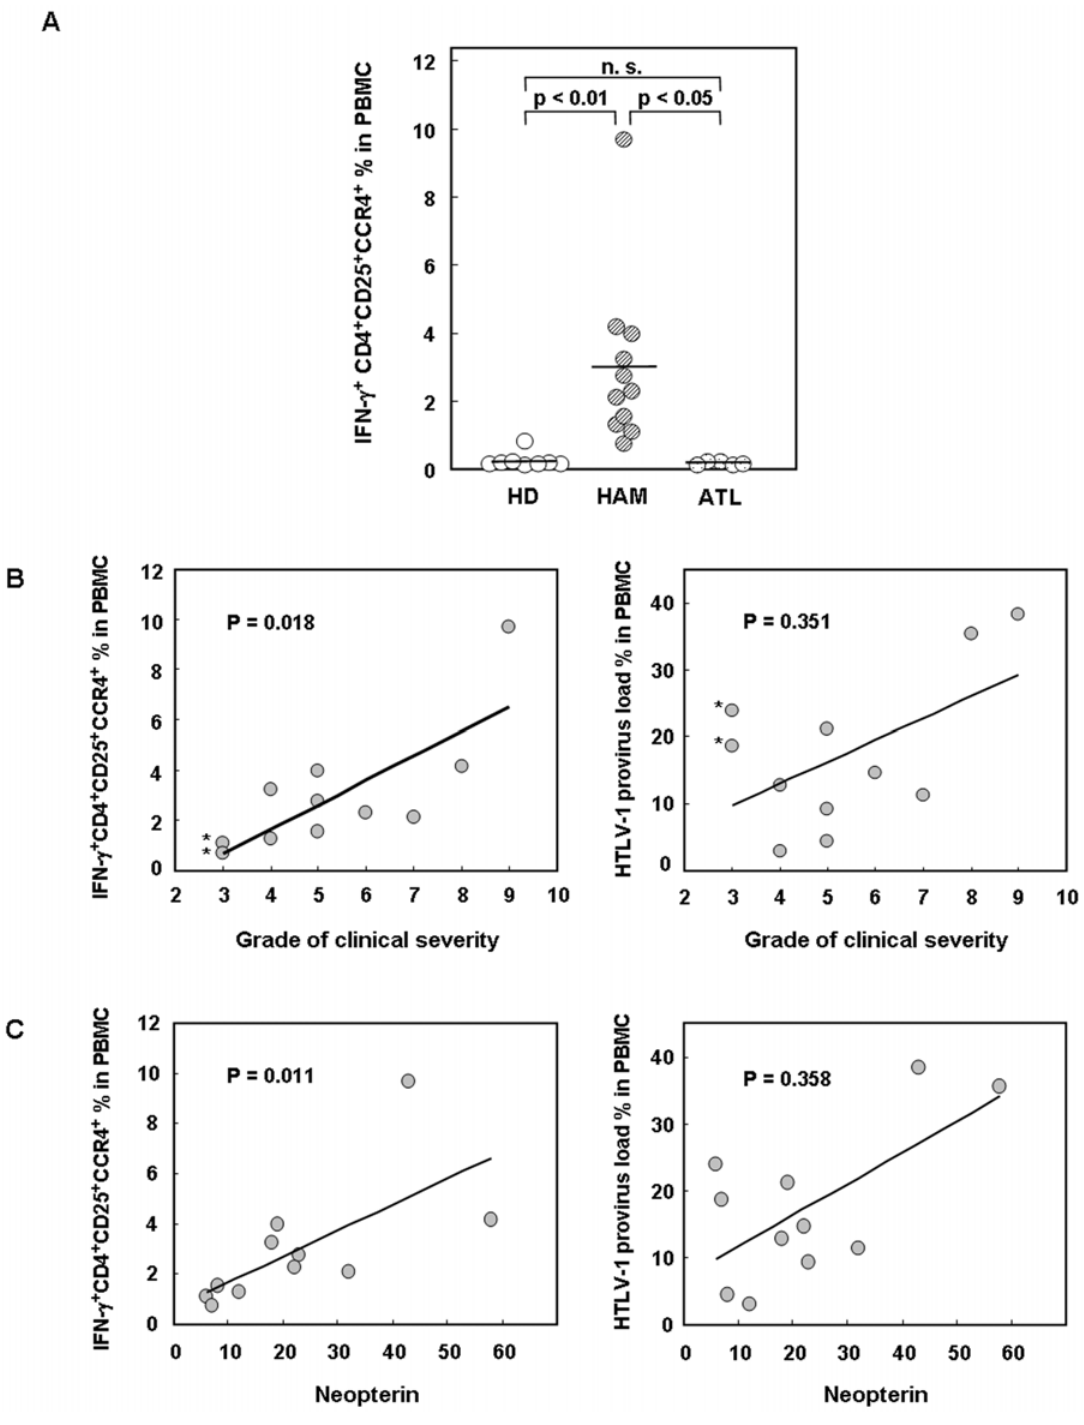
Figure 7. Frequency of IFN- c -producing CD4 + CD25 + CCR4 + Foxp3 2 T cells is increased and correlates with HAM/TSP disease severity. A. Percentage of IFN- c + CD4 + CD25 + CCR4 + T cells to the total PBMCs in 8 HDs, 11 HAM/TSP patients, and 5 ATL patients. The horizontal bar indicates the mean value of each group. Scheffe’s test (nonparametric) was used for statistical analysis. n.s. not significant. B. Correlation between HAM/TSP disease severity and the frequency of IFN- c -producing CD4 + CD25 + CCR4 + T cells in PBMCs or the HTLV-1 provirus load in PBMCs. According to Spearman’s rank correlation test, the frequency of IFN- c + CD4 + CD25 + CCR4 + T cells correlated with disease severity (p=0.018), while the HTLV-1 provirus load did not (p=0.351). * indicates HAM/TSP patients with disease severity of a low grade and high provirus load. C. Correlation between neopterin concentration in CSF and the frequency of IFN- c -producing CD4 + CD25 + CCR4 + T cells in PBMCs or the HTLV-1 provirus load in PBMCs. According to Spearman’s rank correlation test, the frequency of IFN- c + CD4 + CD25 + CCR4 + T cells correlated with CSF neopterin concentration (p=0.011), while the HTLV-1 provirus load did not (p=0.358).